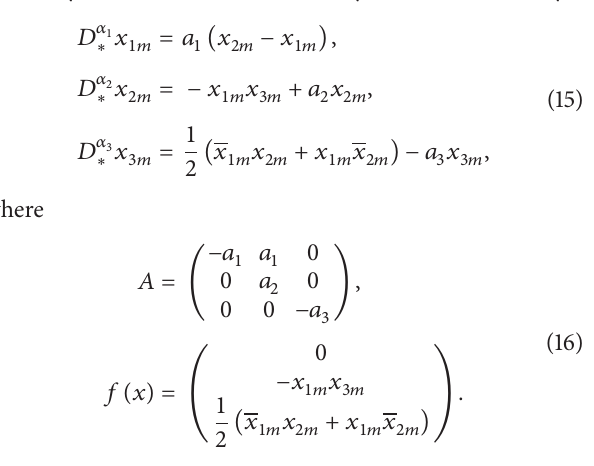
Substituting (10) into (13), the error dynamical system (13)